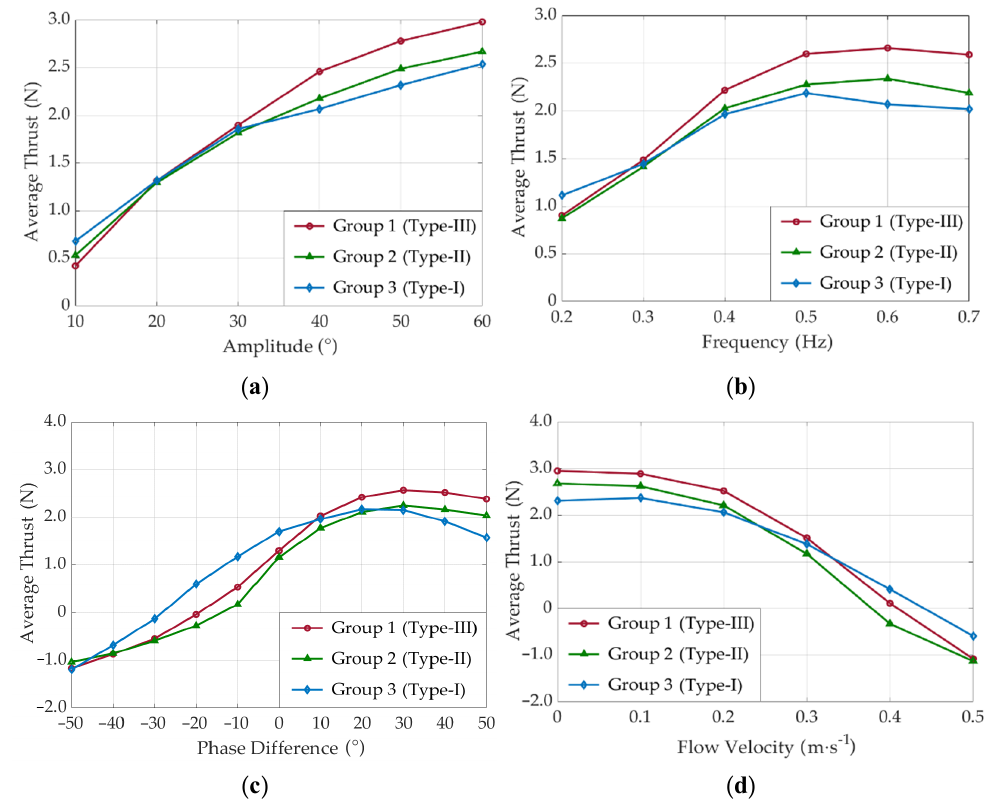
Figure 9. Average thrust comparison among different fin groups. ( a ) The influence of amplitude on average thrust; ( b ) The influence of frequency on average thrust; ( c ) The influence of phase difference on average thrust; ( d ) The influence of flow velocity on average thrust.